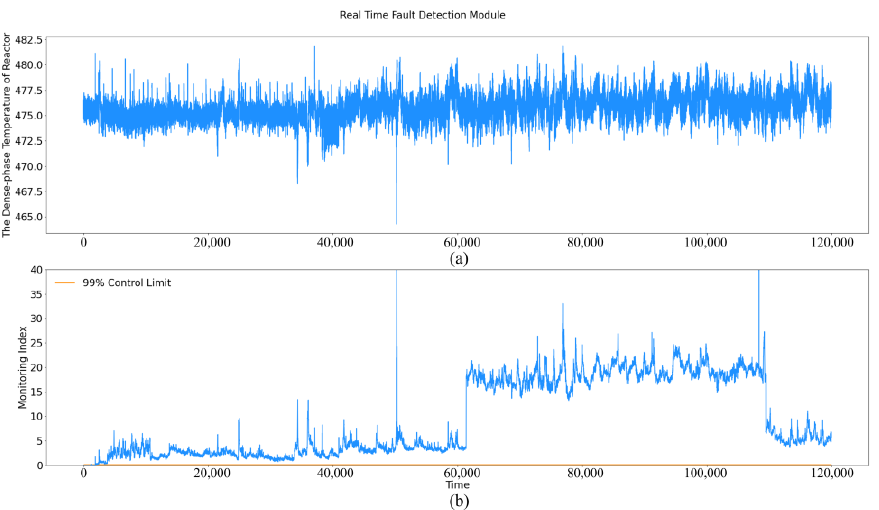
Figure 9. Three-month online process monitoring results (the model is trained with data labeled by semi-supervised deep learning-based method): ( a ) Original data of the key variable; ( b ) Fault detection results.